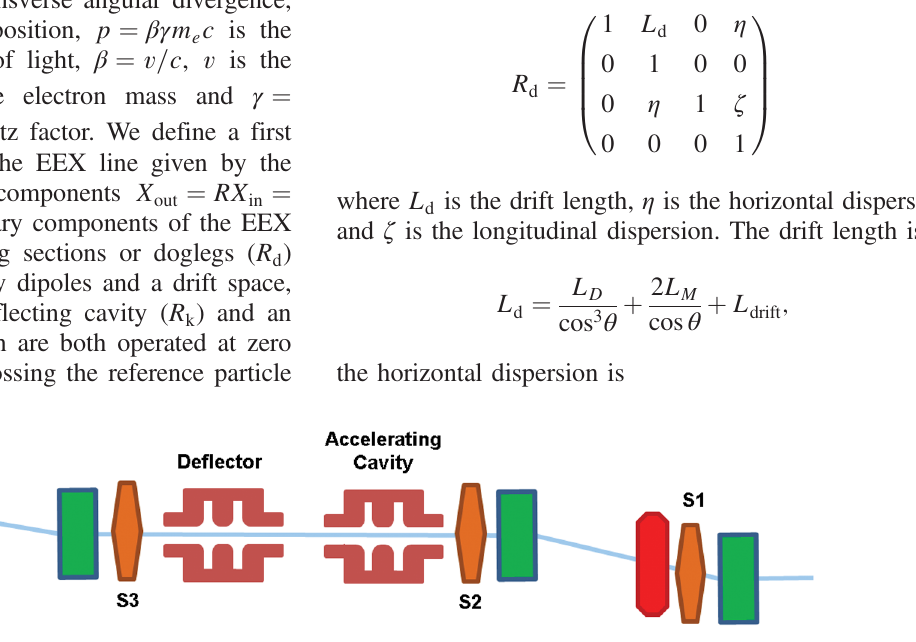
FIG. 1. Schematic of the EEX line showing the primary components of the system. It consists of two doglegs separated by a short straight section containing deflecting and accelerating rf cavities. The electron beam enters from the left with the reference electron trajectory shown with a blue line. Green squares represent bending magnets, orange hexagons represent sextupoles and the red octagon represents an octupole. The total length is approximately 2